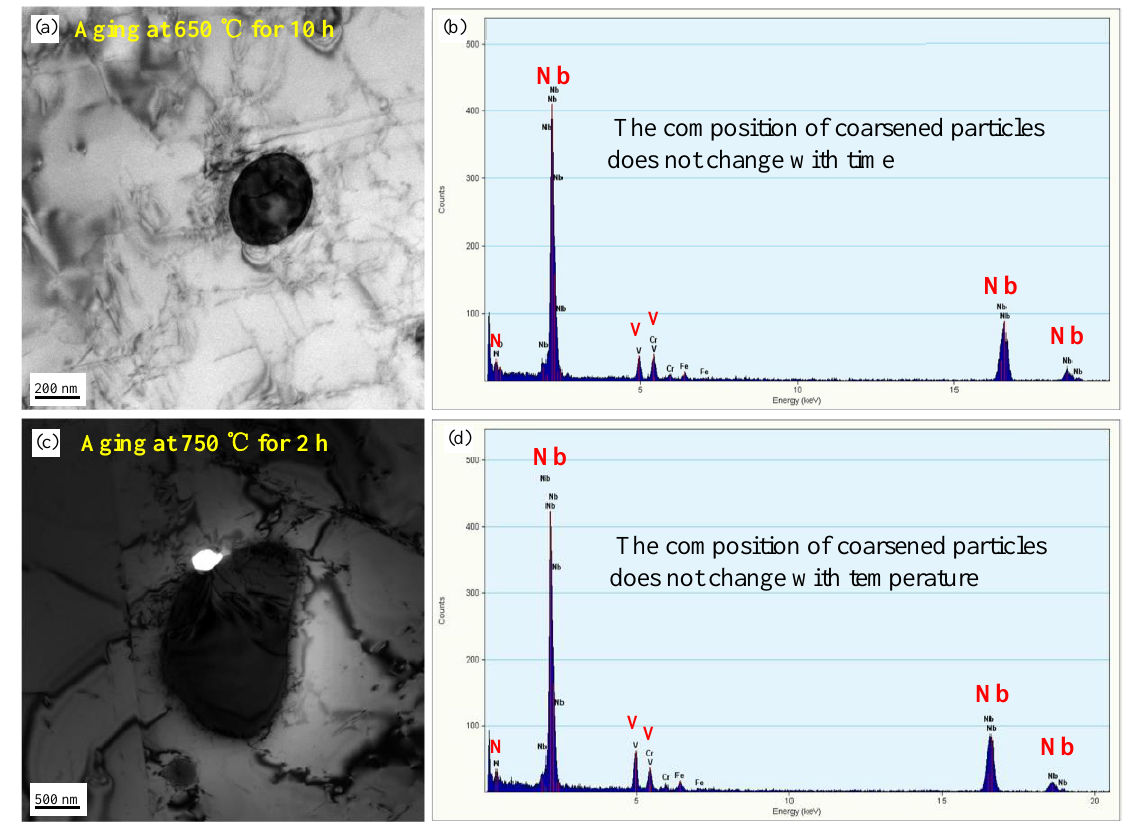
Figure 9. TEM and EDS analysis of elements in the steel after aging treatment. ( a,b ) aging at 650 °C for 10 h, ( c,d ) aging at 750 °C for 2 h.